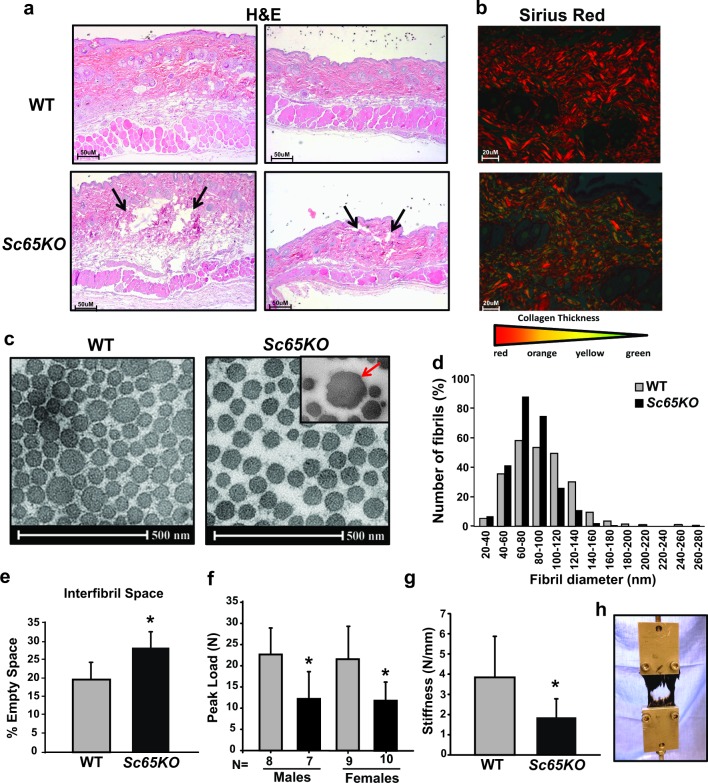
Loss of Sc65 results in dermal tears, abnormal collagen fibrils and skin fragility.a) H&E stained sections of WT and Sc65KO skin. Note the decreased density of collagen, the frayed dermis indicated by arrows and the reduced thickness of the muscle layer in the Sc65-null samples. b) Serial skin sections were stained with Sirius red. Sc65-null skin exhibits fewer large collagen fibers (red staining) and greater number of smaller collagen fibers stained in green compared to WT counterparts. c) Electron micrographs of 7 month-old mouse skin biopsy from WT and Sc65KO mice. Collagen fibrils, shown in cross-section, from Sc65-null skin tended to be smaller and have a decreased range of fibril diameter compared to WT fibrils. Loss of Sc65 also resulted in the presence of collagen fibrils with irregular profile and several large “cauliflower-like” fibrils (red arrow) which indicate abnormal fibrillogenesis (scale bar represents 500nm). d) Distribution of collagen fibril diameter in WT and Sc65KO mouse skin as measured from electron microscopy images. Measurements were collected from three different mice/genotype and >200 fibril/mouse. e) Skin EMs from Sc65KO mice also exhibited significantly more empty space among collagen fibrils compared to WT mice indicating a less densely packed collagen (*p = 0.01). Five electron micrograph images of non-overlapping areas were quantified from each mouse. f-h) Skin samples from WT and Sc65KO mice were subjected to a biomechanical skin loading test to measure tensile strength. Skin that lacks SC65 expression ruptured at a significantly lower peak load compared to WT skin indicating significant skin fragility (*p<0.01).